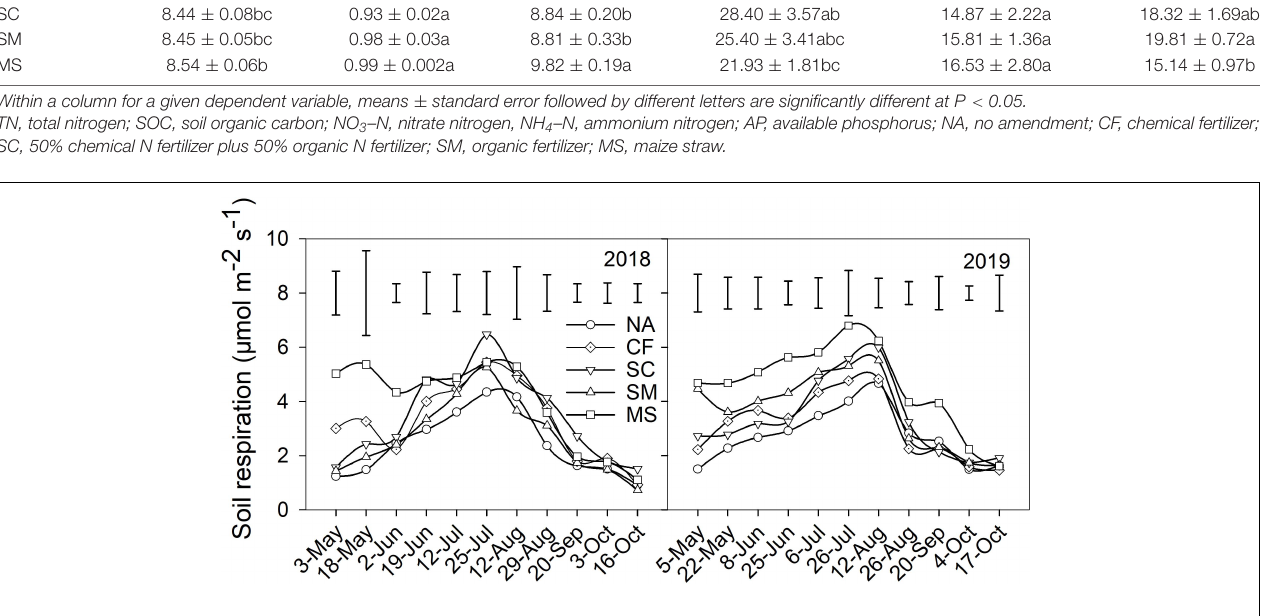
P < 0.01), while the community composition was significantly correlated with SOC ( r = 0. 74, P < 0.01) ( Table 3 ). The diversity and composition of soil autotrophic bacterial community had significantly positive relationships with TCE ( r = 0.75, P <